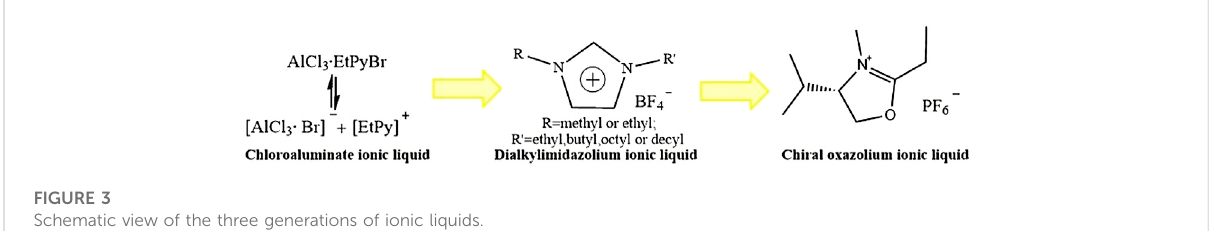
FIGURE 3 Schematic view of the three generations of ionic liquids.